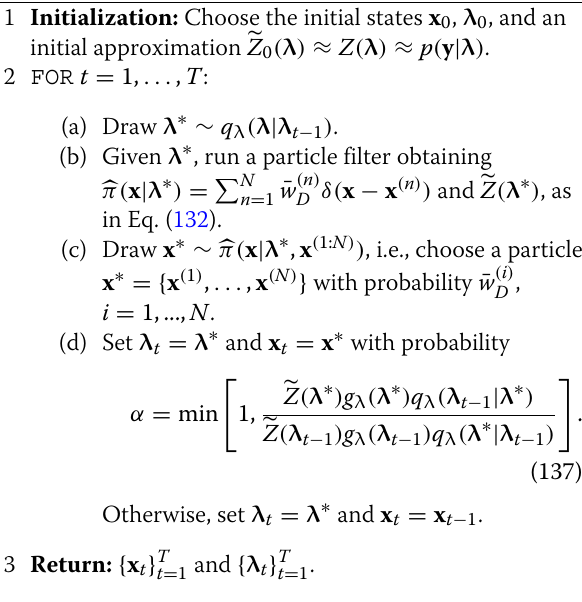
Algorithm 27 Particle Marginal MH